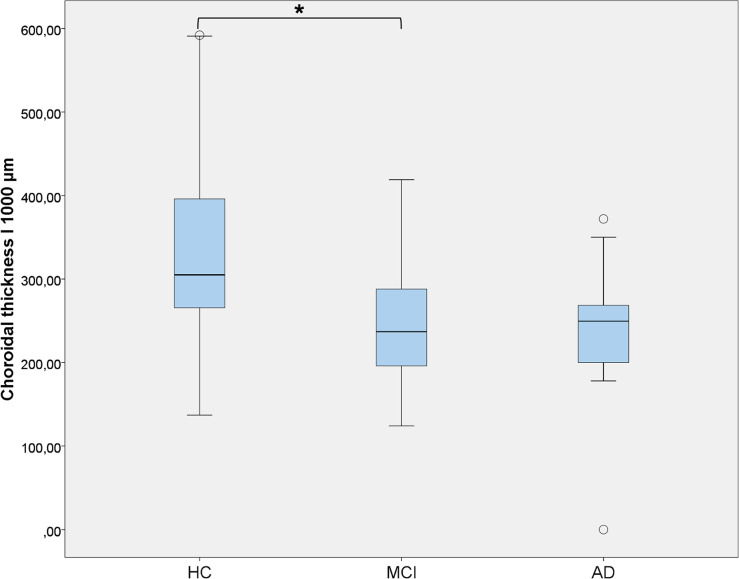
AUC of CT I1000μm in MCI patients, dementia patients and HCs.Choroidal thickness (CT) at 1000 μm in inferior (I) sector in healthy controls (HCs), mild cognitive impairment (MCI) and dementia due Alzheimer’s disease (AD) eyes (error bars represent 95% confidence intervals), described on a bar chart.